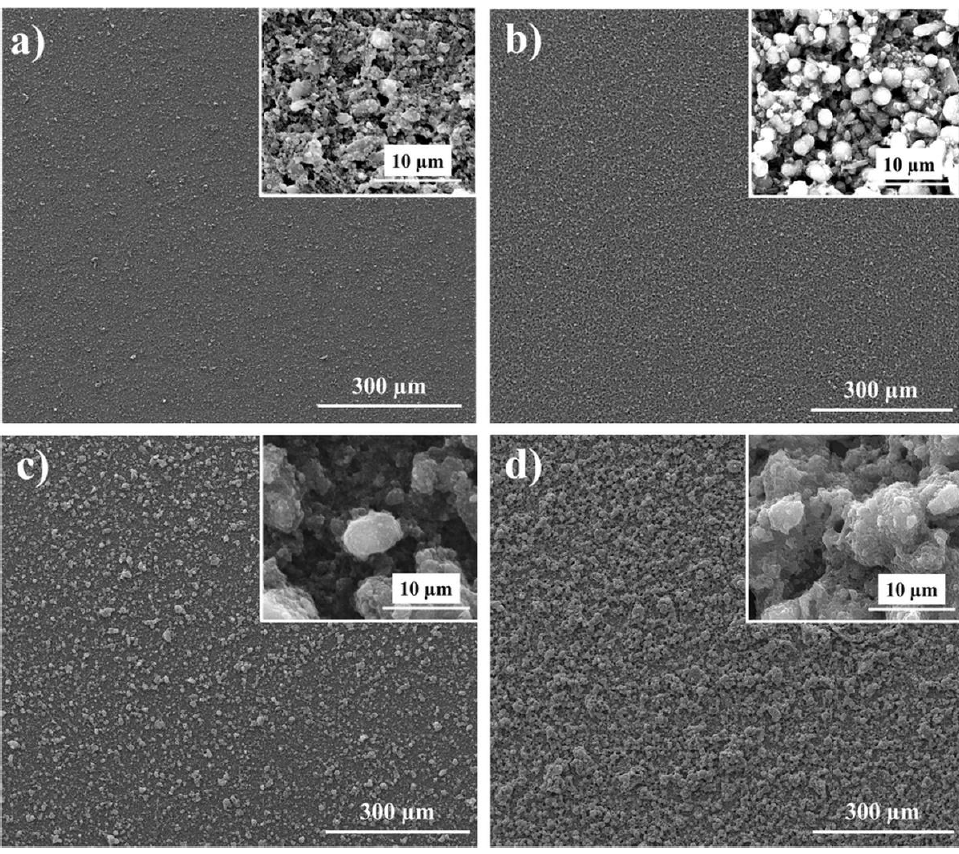
Figure 8. SEM images of the TiO 2 photoanodes ( a ) PhA 1, ( b ) PhA 2, ( c ) PhA 3, and ( d ) PhA4.